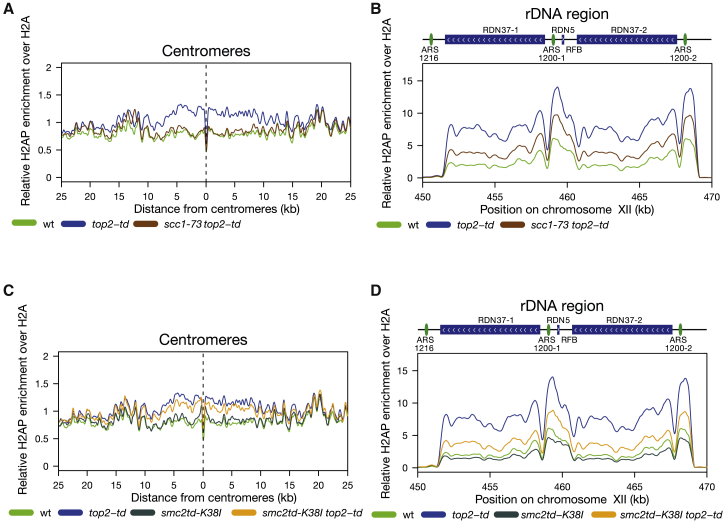
Inactivation of Cohesin Suppresses H2AS129P Enrichment around Centromeres, although Inactivation of Cohesin or Condensin Suppresses H2AS129P Enrichment across the rDNA Repeats(A) The relative enrichment of H2AS129P over H2A ChIP around centromeres is shown for scc1-73 top2-td (brown), released into the cell cycle under the restrictive conditions. Data for WT parental cells (green) and top2-td cells (blue) from Figure 1 are shown for comparison. Graph shown is generated from a pile up of the profiles of all centromeres and is an average of two repeats.(B) The relative enrichment of H2AS129P over H2A ChIP over the rDNA repeats is shown for scc1-73 top2-td (brown), released into the cell cycle under the restrictive conditions. Data for WT parental cells (green) and top2-td cells (blue) from Figure 1 are shown for comparison. Graph shown is an average of two repeats.(C) The relative enrichment of H2AS129P over to H2A ChIP across centromeres is shown for smc2-td K38I cells (where Smc2 protein is depleted and an enzymatically inactive form of Smc2 smc2K38I is concurrently expressed; dark gray) and smc2td K38I top2-td cells where both smc2 and Top2 are depleted and smc2K38I expressed (orange), both released into the cell cycle under the restrictive conditions. Data for WT parental cells (green) and top2-td cells (blue) from Figure 1 are shown for comparison. Graph shown is generated from a pile up of the profiles of all centromeres and is an average of two repeats.(D) The relative enrichment of H2AS129P over H2A ChIP over the rDNA repeats is shown for smc2-td K38I cells (where Smc2 protein is depleted and an enzymatically inactive form of Smc2, smc2K38I, is concurrently expressed; dark gray) and smc2-td K38I top2-td cells where both smc2 and Top2 are depleted and smc2K38I expressed (orange), both released into the cell cycle under the restrictive conditions. Data for WT parental cells (green) and top2-td cells (blue) from Figure 1 are shown for comparison. Graph shown is an average of two repeats.See also Figures S3 and S7.